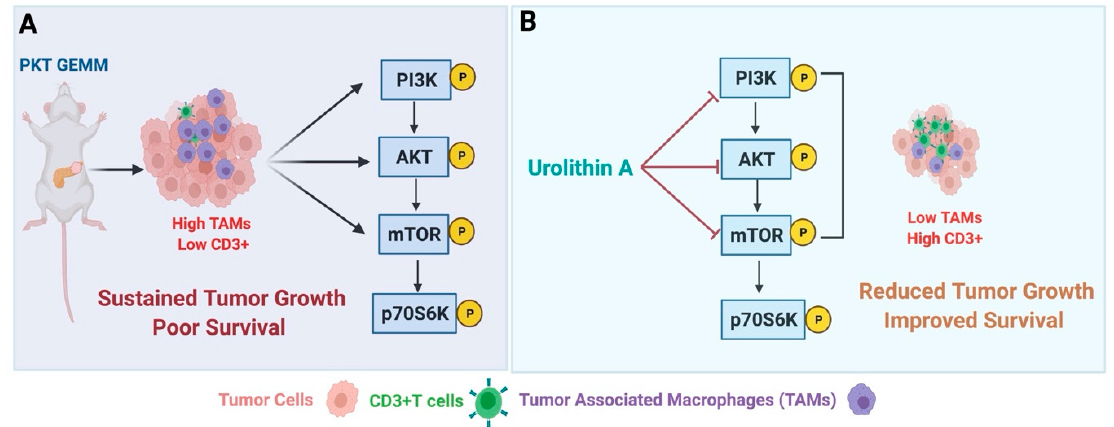
Figure 2. Schematic representation showing the effect of Uro A in a genetically engineered mouse model (GEMM) of PDAC. ( A ) Ptf1a Cre/+ ; LSL-Kras G12D/+ ; Tgfbr2 flox/flox (PKT) GEMM showing sustained pancreatic tumor growth, presence of immunosuppressive tumor-associated macrophages (TAMs), lack of CD3+T cells, and activated PI3K/AKT/mTOR signaling axis within the microenvironment of a highly aggressive Ptf1a Cre/+ ; LSL-Kras G12D/+ ; Tgfbr2 flox/flox (PKT) genetically engineered mouse model (GEMM) of PDAC. ( B ) Treatment with Urolithin A (Uro A) intercedes its anti-tumor effects by targeting PI3K/AKT/mTOR kinase pathways to overcome immunosuppressive tumor microenvironment, thereby reducing TAMs and increases CD3+T cells. PKT mice treated with Uro A displayed reduced tumor growth and